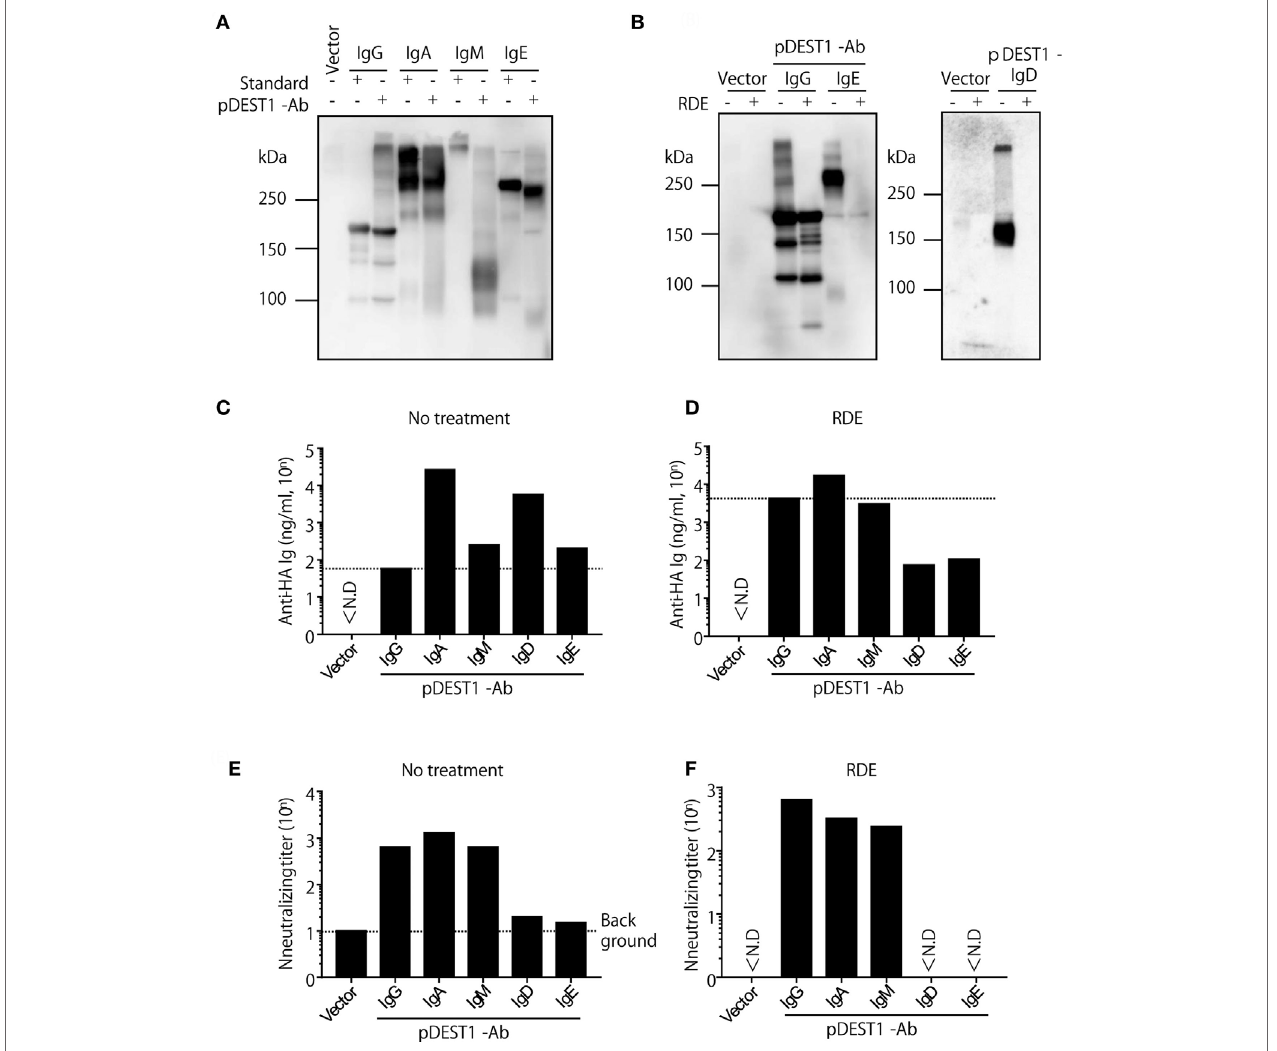
FigUre 4 | Anti-HA IgG, IgA, and IgM neutralize influenza virus in vitro. (a–F) HEK293T cells were co-transfected with pCADEST1-empty (vector) or pCADEST1- anti-HA kappa and anti-HA IgG, anti-HA IgA and Joining chain, anti-HA IgM and Joining chain, anti-HA IgD, or anti-HA IgE. Supernatants were collected after 1 week. (B,D,F) The supernatants were treated with receptor destroying enzyme (RDE) for overnight at 37°C. (a,B) The supernatants were processed by western blotting under non-reducing conditions followed by probing with HRP-conjugated goat anti-mouse IgG, IgA, IgM, and IgE. For detecting IgD, the blotted supernatants were probed with APC-conjugated rat anti-mouse IgD followed by HRP-conjugated anti-rat IgG. The indicated data are representative of two independent experiments. (c,D) The concentration of anti-HA antibodies in the supernatants was measured by competitive ELISA. A 96-well plate coated with HA was incubated with the supernatants, followed by addition of biotin-conjugated anti-HA IgG monoclonal antibody (mAb). (e,F) The neutralizing antibody titer was measured by a micro-neutralization assay. ND, not